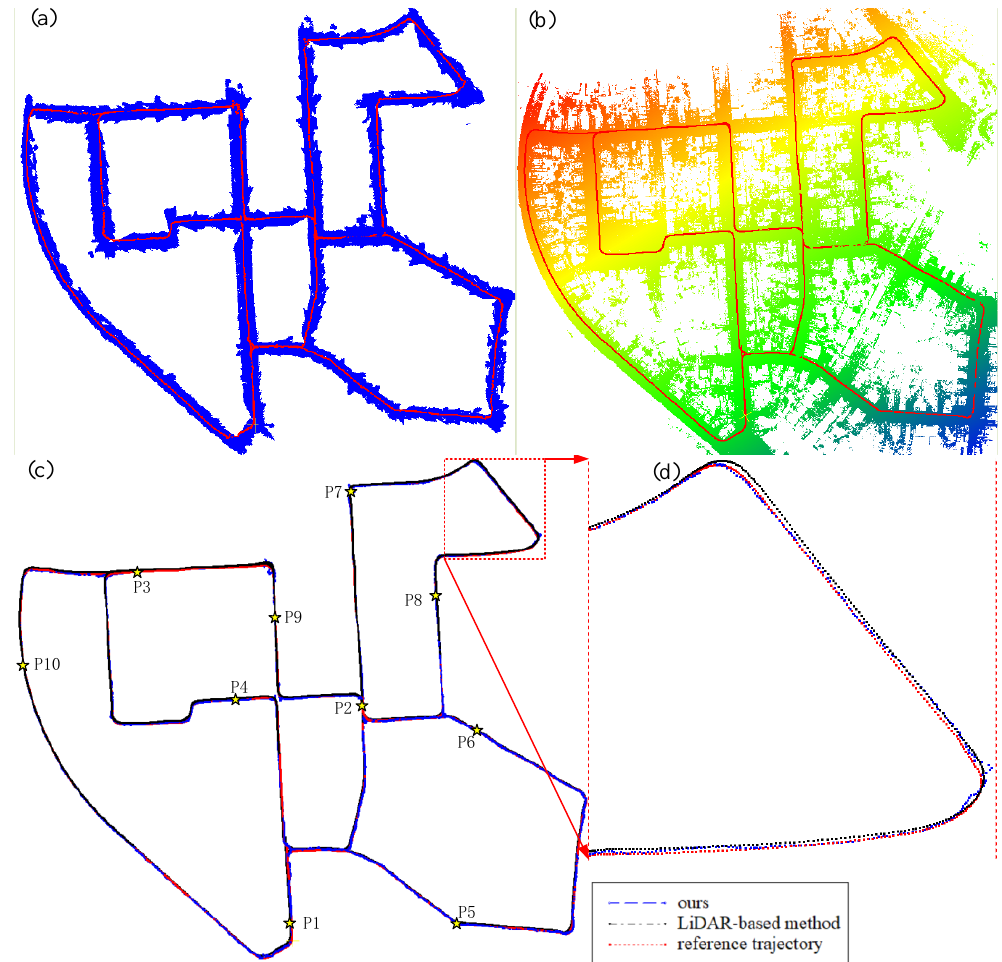
Figure 10. Comparison between the proposed method and LiDAR-based method with the sequence 00 of KITTI dataset. ( a ) Top view of the proposed method; ( b ) top view of LiDAR-based method; ( c ) comparison of horizontal segment localization results; ( d ) local enlargement of localization result. Table 2. Comparison of horizontal segment localization errors between the proposed method and LiDAR-based method.